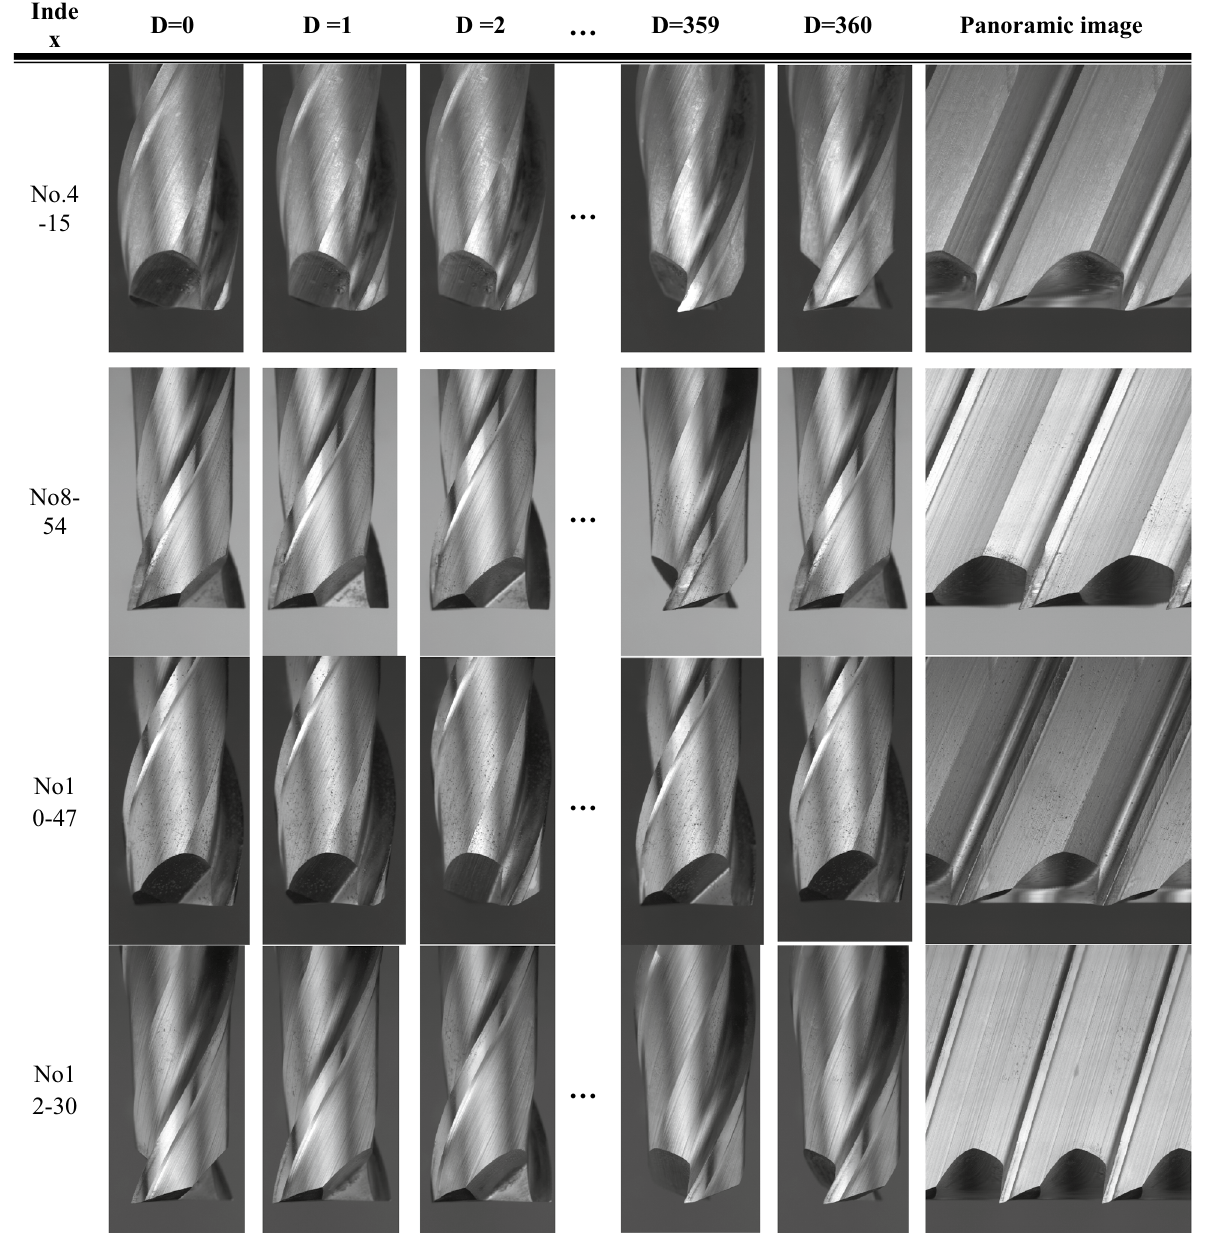
Table 2. The expanded panorama images with different phases of each spiral cutting